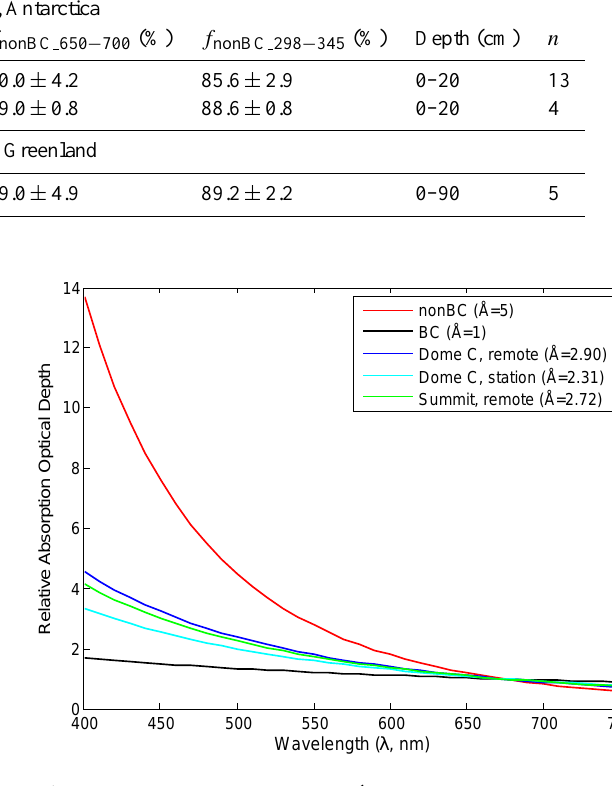
Fig. 1. Idealized absorption profiles (expressed in absorption optical depth, T ( λ )) of BC (black) and nonBC (red) material from Grenfell et al. (2011) and Hoffer et al. (2006). Also shown are absorption profiles of snow samples collected in remote Dome C (blue), remote Summit (green), and near-station Dome C